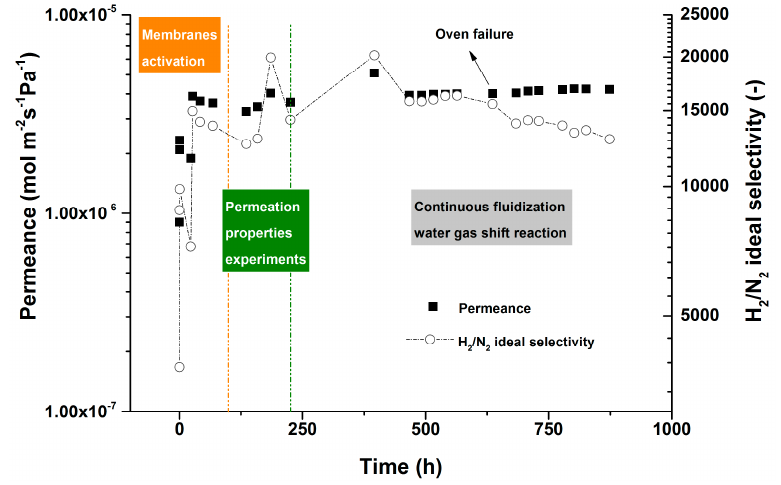
Figure 4. Long-term performance of the membrane module during 900 h of continuous operation in the bubbling fluidization regime at high-temperature WGS conditions. Temperature: 400 °C, P permeate : 1 bar, P retentate : 2 bar; feed: 10 NL/min of pure H 2 . P permeate : 1 bar, P retentate : 2 bar; feed: 10 NL/min of pure H 2